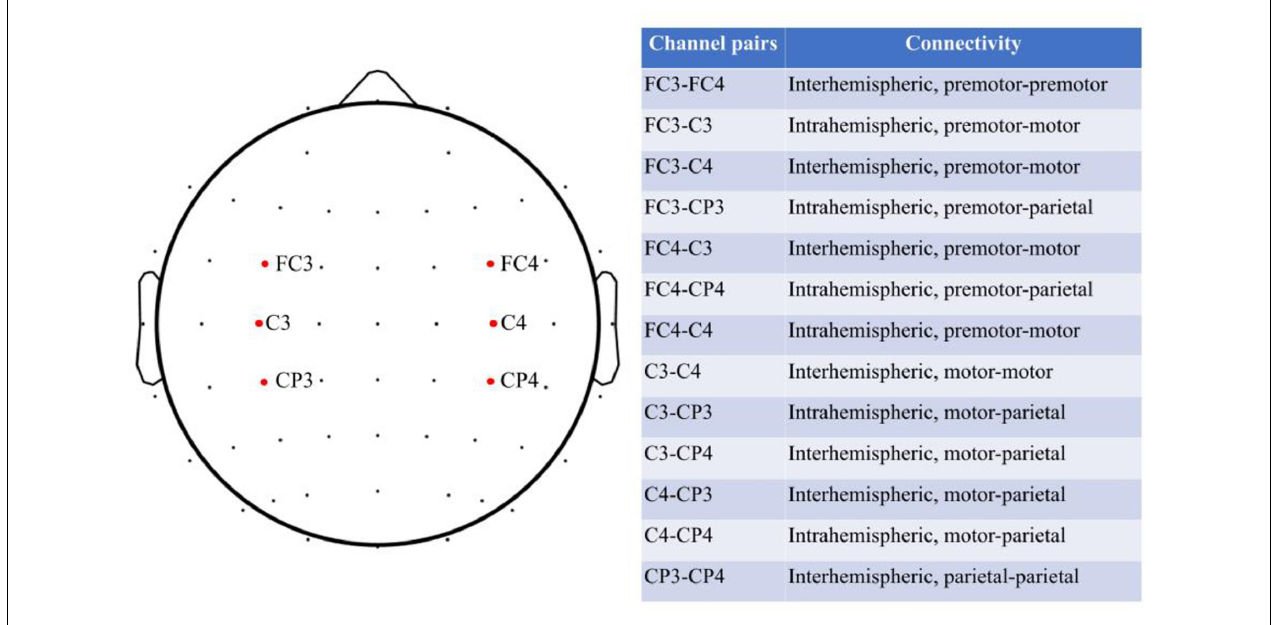
FIGURE 2 | Channel pairs of